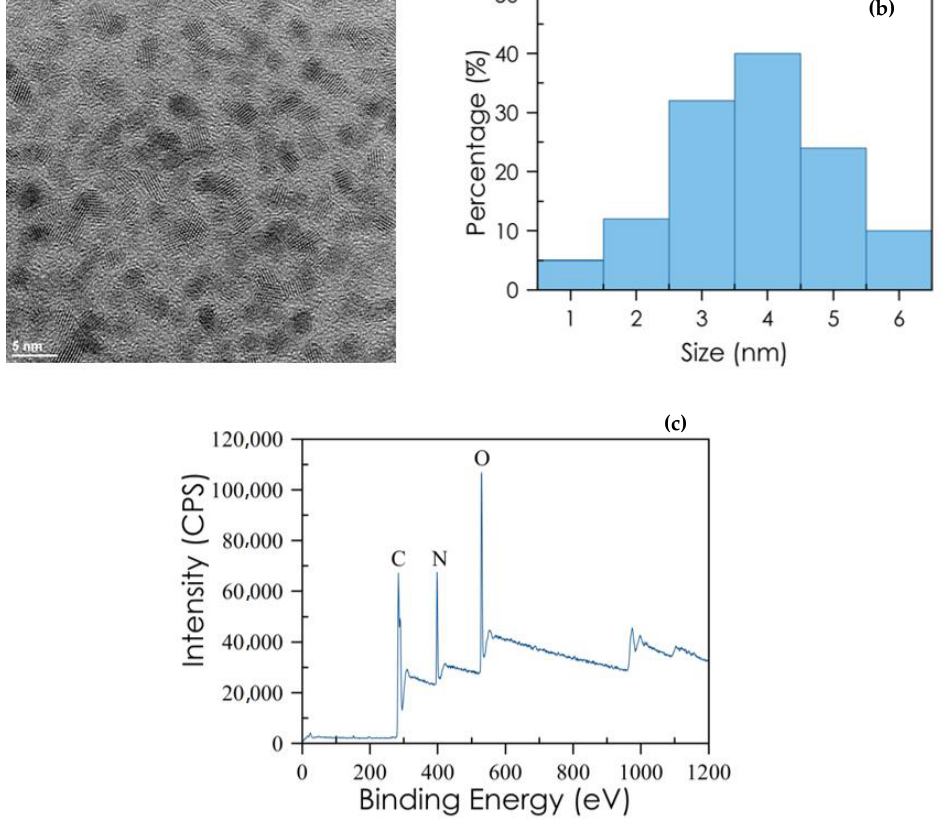
Figure 2. Characterization of the CDs. ( a ) HR-TEM image; ( b ) size distribution for CDs; ( c ) XPS spectra: C1s peak: 284 eV; N1s peak: 398 eV and O1s peak: 530.